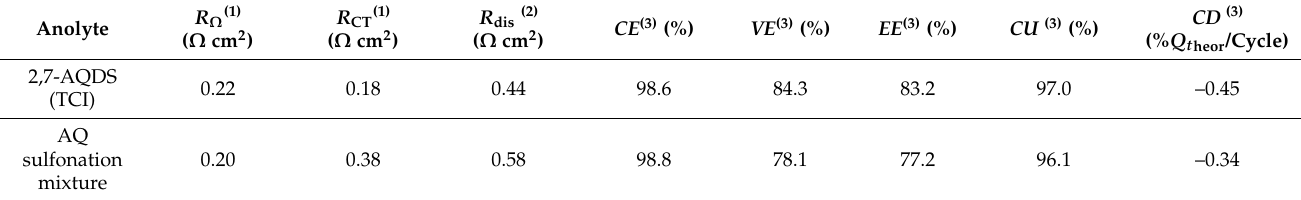
Table 1. AQDS-HBr single-cell parameters with different AQDS-based anolytes.